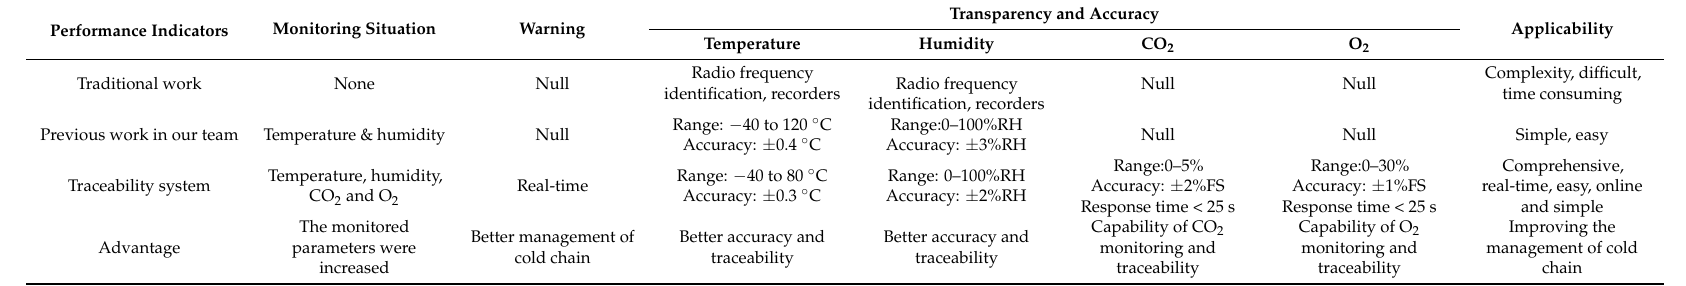
Table 6. The performance analysis of the